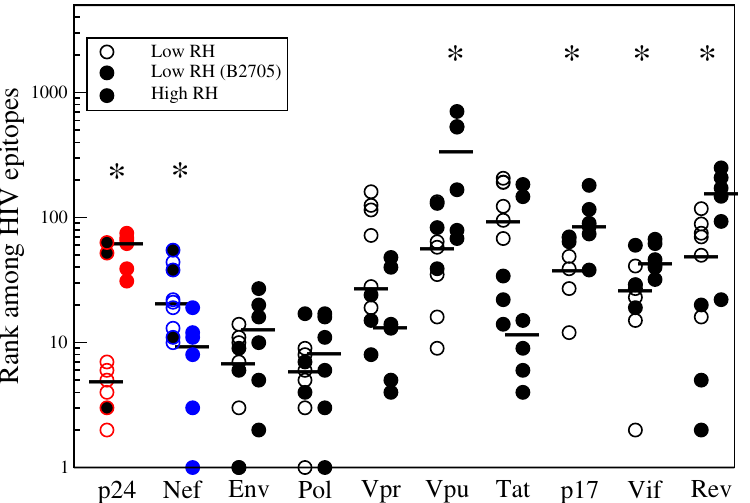
Figure 1. Predicted ranks of epitopes from different HIV-1 proteins. HLA-binding epitopes were predicted for HLA alleles with a low RH (HLA- B5701, HLA-B5801 and HLA-B2705) and HLA alleles with a high RH (HLA-B3503 and B5301), and their rank among all other HIV-1 epitopes was plotted. Low ranks correspond to good binding peptides. The analyses were limited to the three best-binding epitopes from each HIV-1 protein. HLA alleles with a low RH were found to have a significantly higher preference for peptides from p24 than HLA alleles with a high RH ( p =0.01, Mann- Whitney test), while HLA alleles with a high RH had a significantly higher preference for Nef ( p =0.02). A significant difference between low and high RH HLA molecules was also observed for peptides from Vpu ( p =0.01), p17 ( p =0.02), Vif ( p =0.02), and Rev ( p =0.01), but the median ranks of the best-binding peptides from these proteins are so high that these differences are probably not physiologically important. Epitopes for HLA-B2705 are depicted as shaded circles. All predictions were based on a neural-network based predictor (NetMHC); the use of matrix methods gave similar results (results not shown). The number of amino acids in each of the HIV proteins is: p24 231, Nef 206, Env 856, Pol 947, Vpr 96, Vpu 82, Tat 101, p17 132, Vif 192, and Rev 116 amino